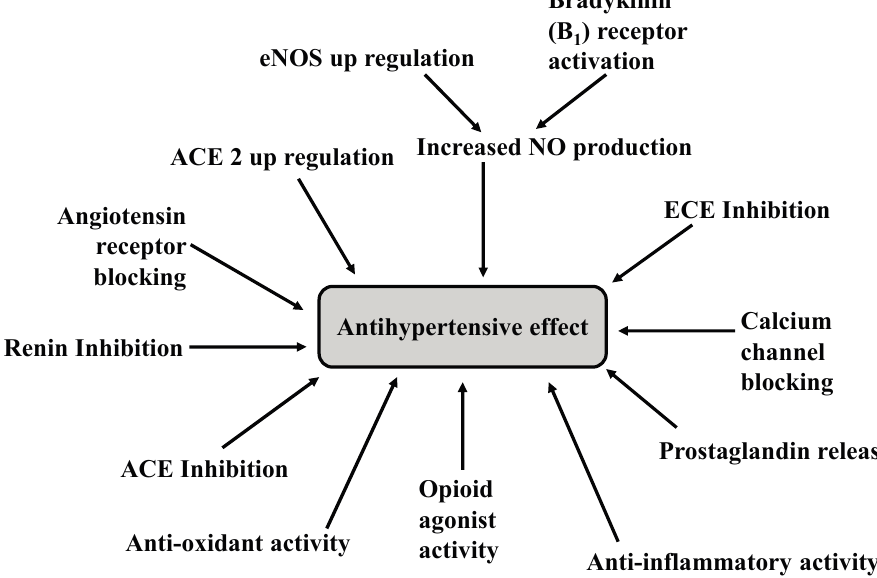
Figure 5. A schematic diagram of antihypertensive mechanism of food derived peptides. ACE (Angiotensin-I converting enzyme), ACE 2 (Angiotensin converting enzyme 2), eNOS (Endothelial nitric oxide synthase), NO (Nitric oxide), ECE (Endothelin converting